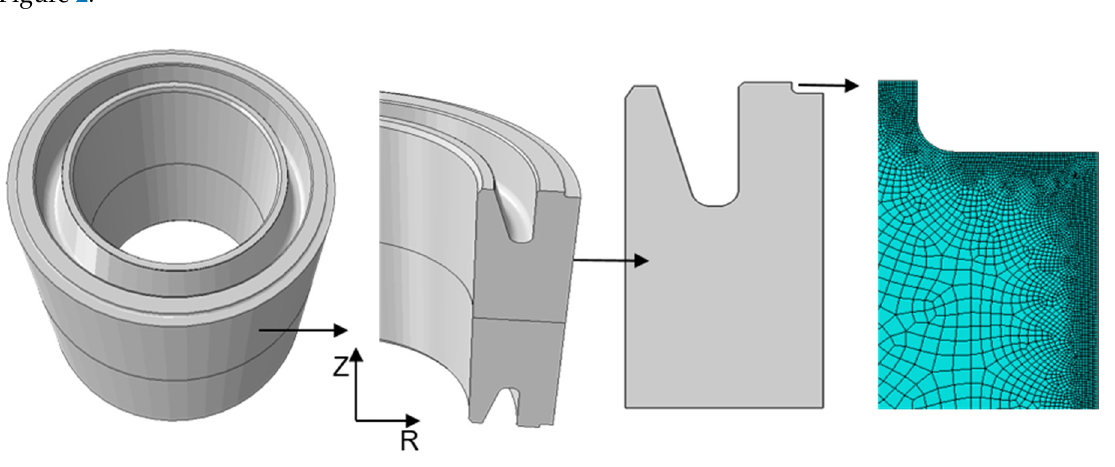
Figure 2. Implemented gear blank geometry and near surface mesh of the 2D axisymmetric model derived from 3D geometry.